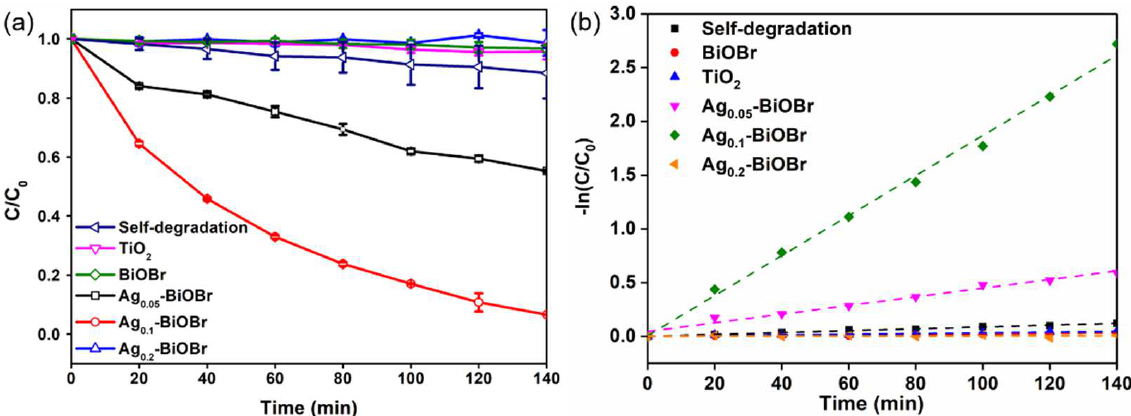
Figure 6. ( a ) Photocatalytic degradation curves and ( b ) corresponding kinetic curves of the BiOBr and Ag-BiOBr samples.